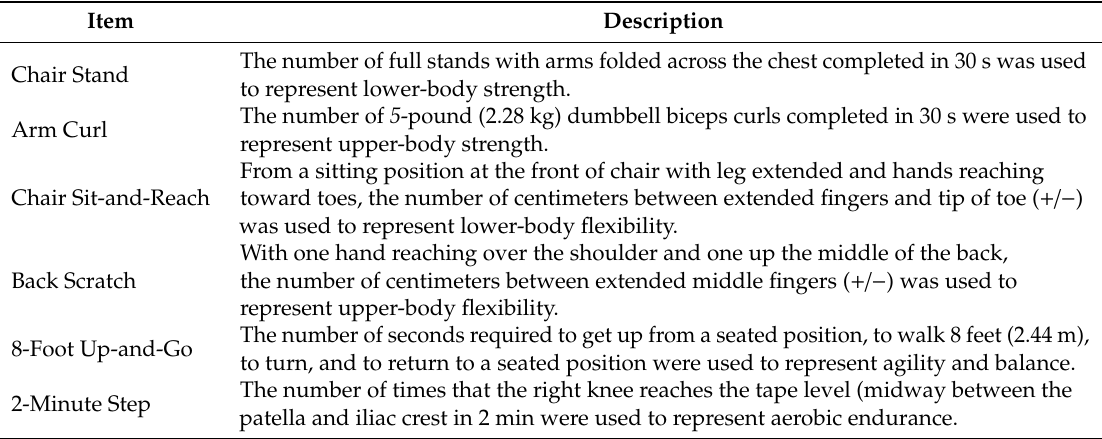
Table 2. Description of senior fitness